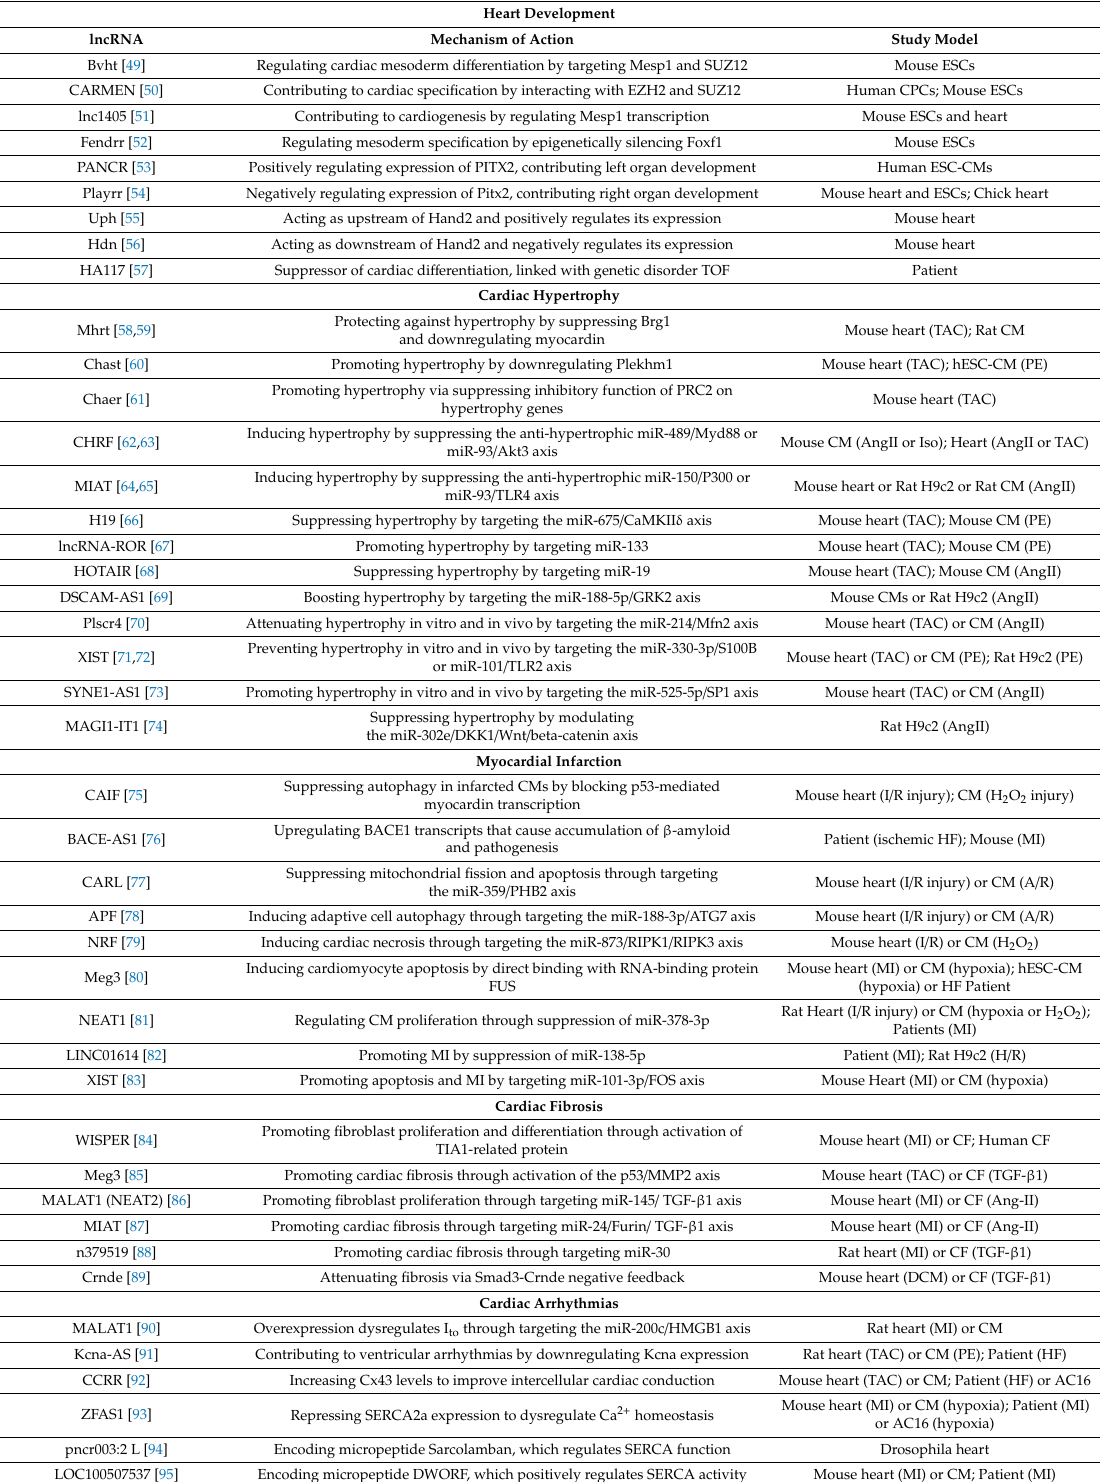
Table 1. Summary of lncRNAs involved in heart development and